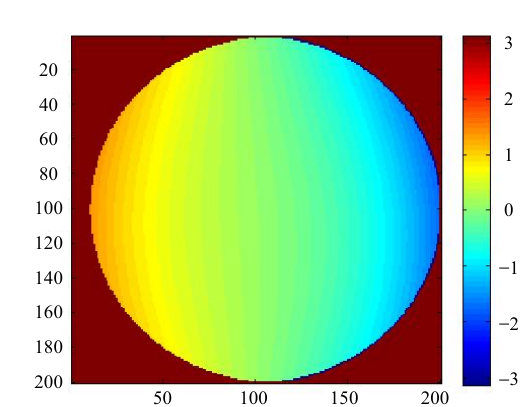
Fig. 4 Restoration phase after removing the zeroth order effect.